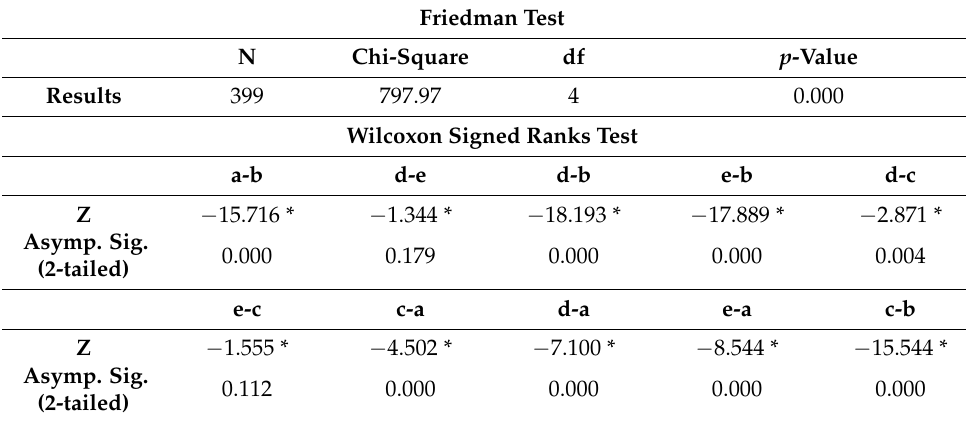
Table 2. Friedman test and Wilcoxon test results for the hypothesis H1. Friedman Test